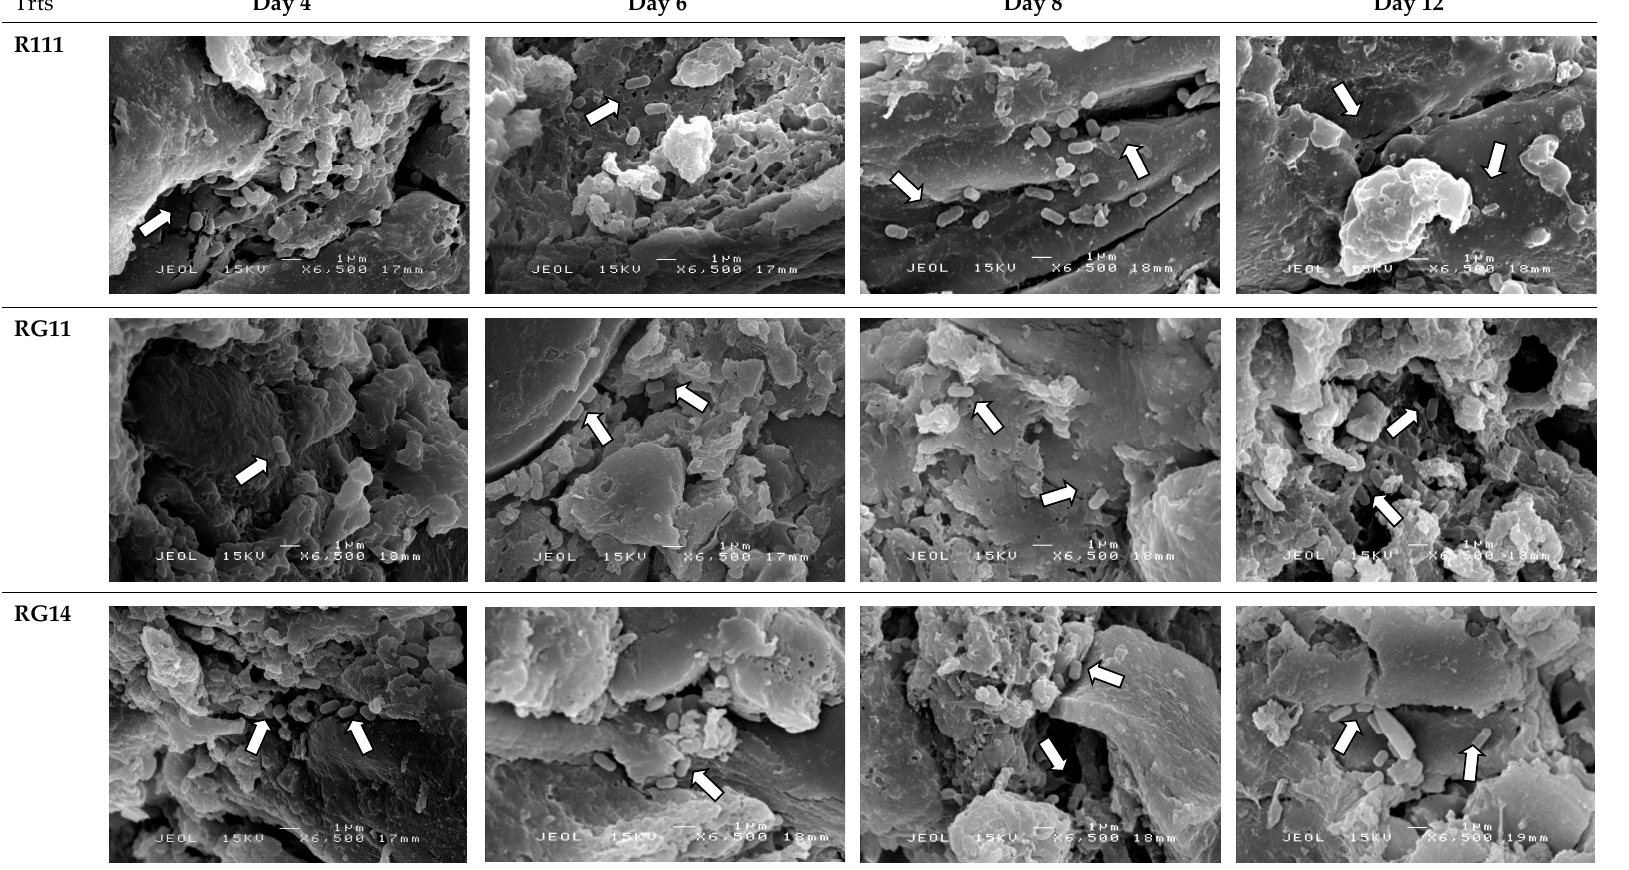
Figure 5. Scanning electron micrographs of treated palm kernel cake by selected Lactobacillus plantarum strains. The magnification was 6,500 x (Bar: 1µm). Abbreviations: R111, L. plantarum R111; RG11, L. plantarum RG11; RG14, L. plantarum RG14. White arrows show the attachment of L. plantarum strains around the grooved, porous, and uneven surfaces of PKC during the SSF of PKC biomass.